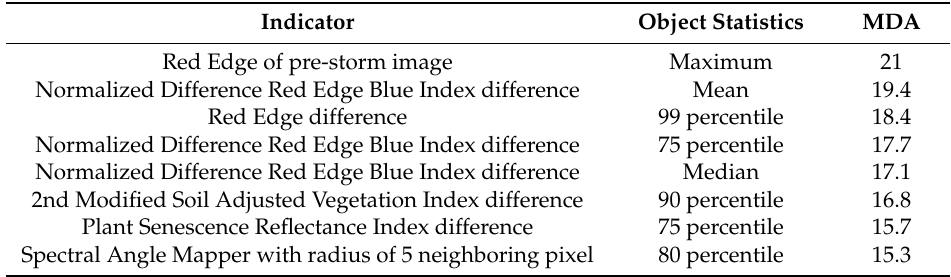
Table 11. Most important object variables in the Random Forest model for the Landsberg study site. The last column indicates the value of the Mean Decrease in Accuracy